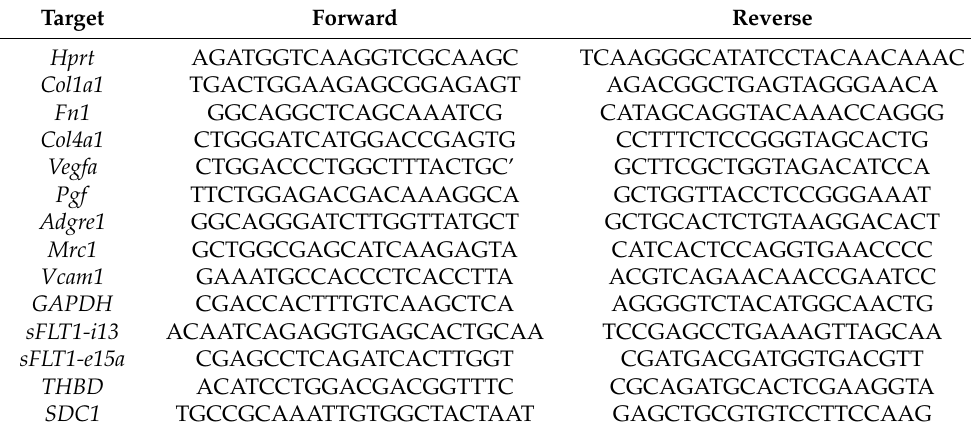
Table 2. Primer sequences for real-time PCR analysis.